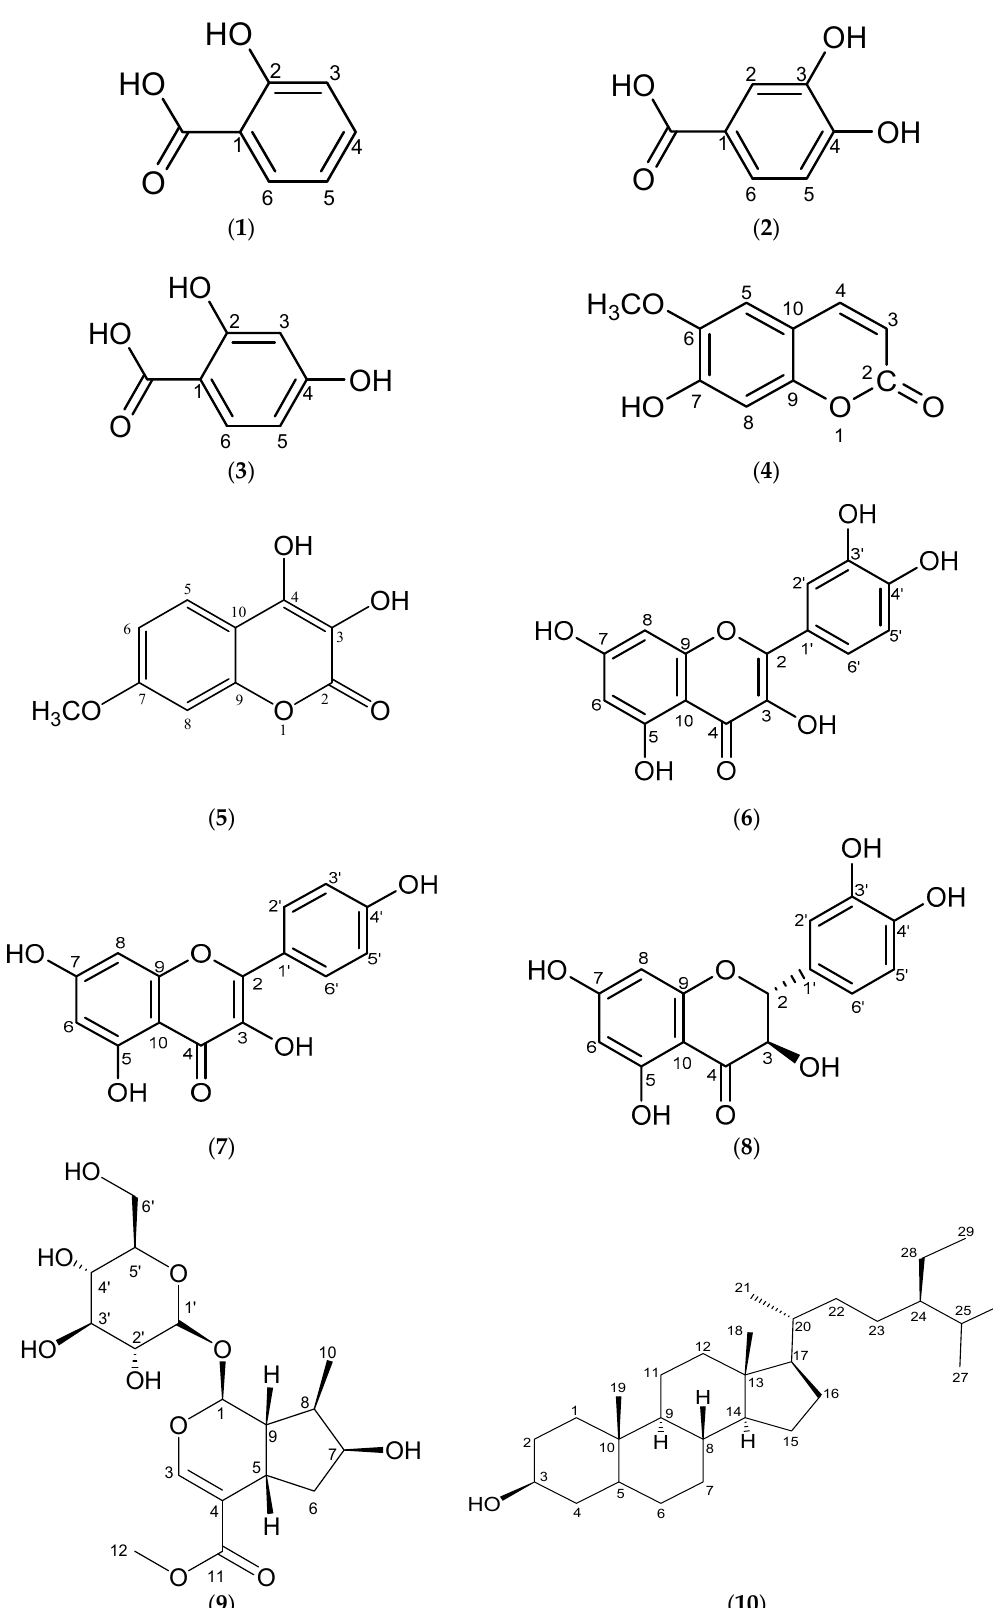
Figure 1. Compounds from Uncaria cordata var. ferruginea . The constituents were identified as 2-hydroxybenzoic acid (salicylic acid), 2,4-dihydroxybenzoic acid, 3,4-dihydroxybenzoic acid, 7-hydroxy-6-methoxycoumarin (scopoletin), 3,4-dihydroxy-7-methoxycoumarin, quercetin, kaempferol, taxifolin, loganin and β -sitosterol.